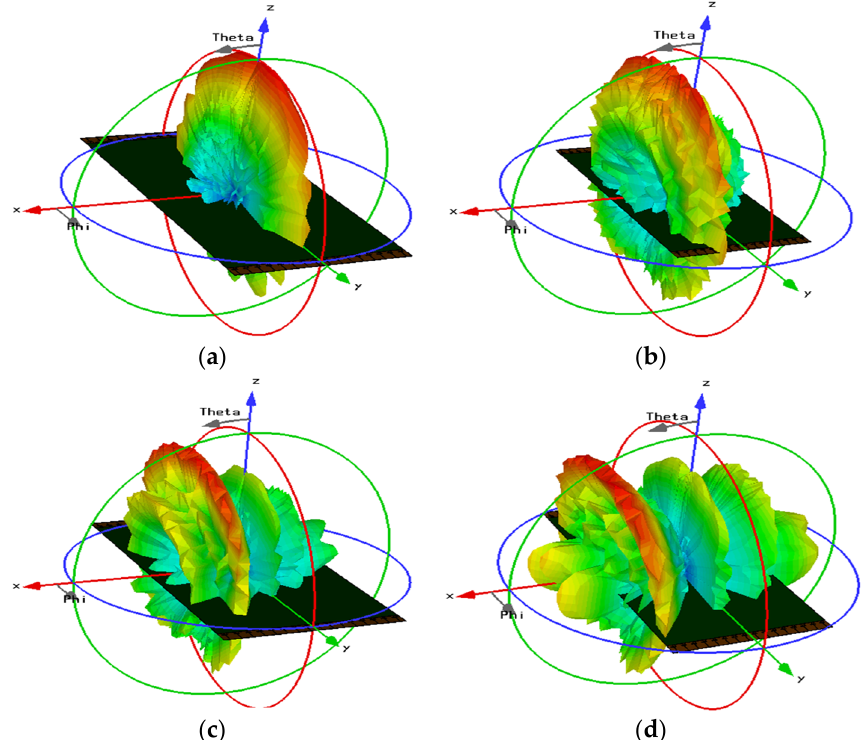
Figure 11. The 3D radiation beams in 38 GHz band at different scanning angles; ( a ) 0°, ( b ) 15°, ( c ) 30° and ( d ) 45°.